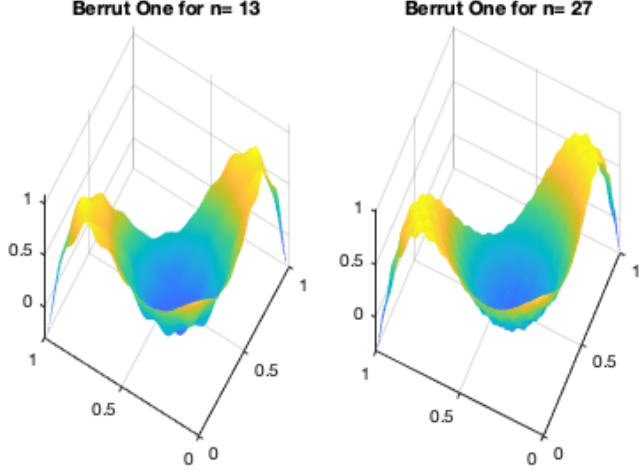
Figure 7. Bivariate Berrut One for f ( x , y ) = sin ( 2 π (( x − 1/3 ) 2 + ( y − 1/3 ) 2 )) , n = 13, 27. A Hybrid Interpolant